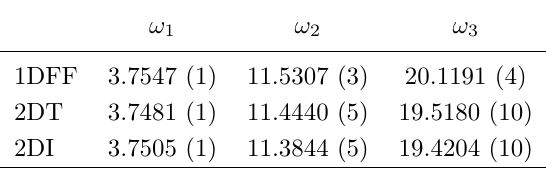
Table 2. Calculated natural frequencies.